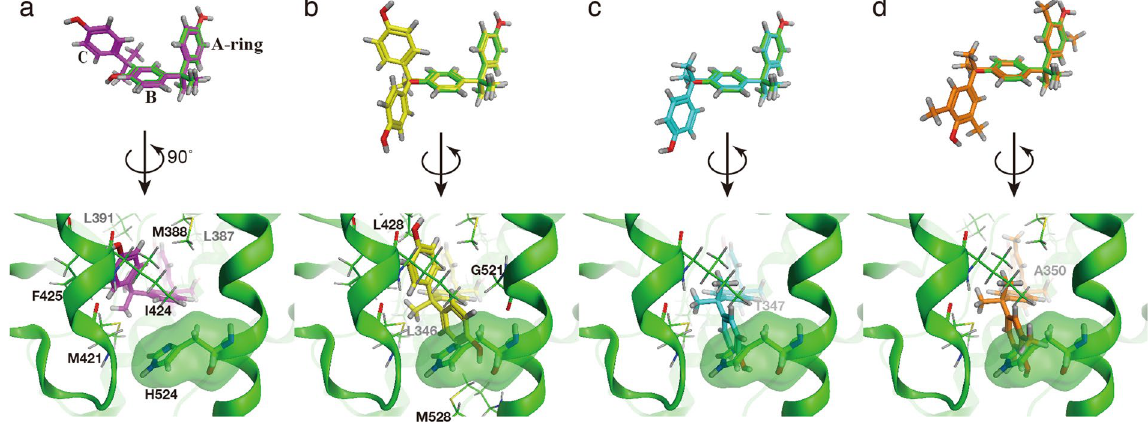
Figure 4. Molecular superposition of tandem tri-ring bisphenols onto the BPA-bound ER α structure. Superposition of tandem tri-ring bisphenols and BPA via the in silico Molecular Superpose function show that the tandem tri-ring bisphenols clash with the side chains of the human ER α structure (PDB ID: 3UUA) in its active conformation. BPM (magenta), α , α , α′ -tris(4-hydroxyphenyl)-1-ethyl-4-isopropylbenzene (yellow), BPP (blue), and α , α′ -bis(4-hydroxy-3,5-dimethylphenyl)-1,4-diisopropylbenzene (orange) are superposed onto the HO-C 6 H 6 -C-C 6 H 6 moiety of BPA. The molecular surface of the H524 residue located in close proximity to the N-terminal of Helix 11 is illustrated in transparent green. ( a ) BPM clashes with L349, A350 (in Helix 3), L387, M388, L391(in Helix 5), M421, I424, and F425 (in Helix 7), ( b ) α , α , α′ -Tris(4-hydroxyphenyl)-1- ethyl-4-isopropylbenzene clashes with L346, A350 (in Helix 3), L387, M388, L391(in Helix 5), M421, I424, F425, L428 (in Helix 7), G521(in Helix 10), H524 and M528 (in Helix 11), ( c ) BPP clashes with L346, T347 (in Helix 3), M421, I424 (in Helix 7), and H524 (in Helix 11), ( d ) α , α′ -Bis(4-hydroxy-3,5-dimethylphenyl)-1,4-